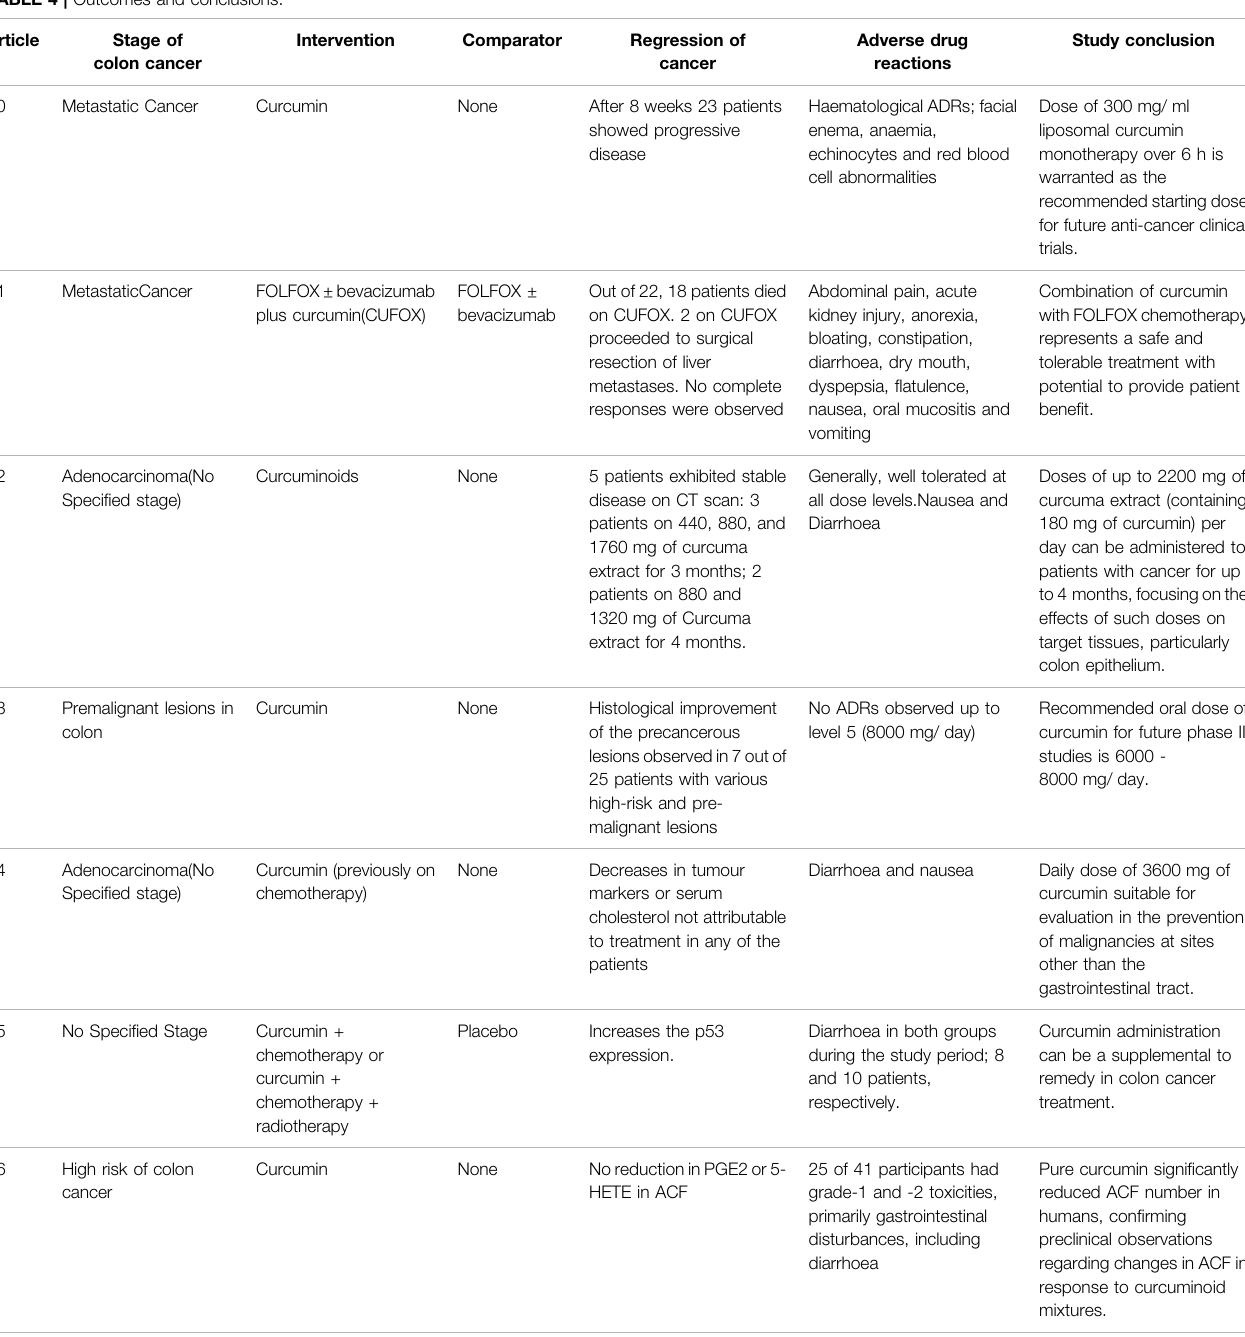
TABLE 4 | Outcomes and